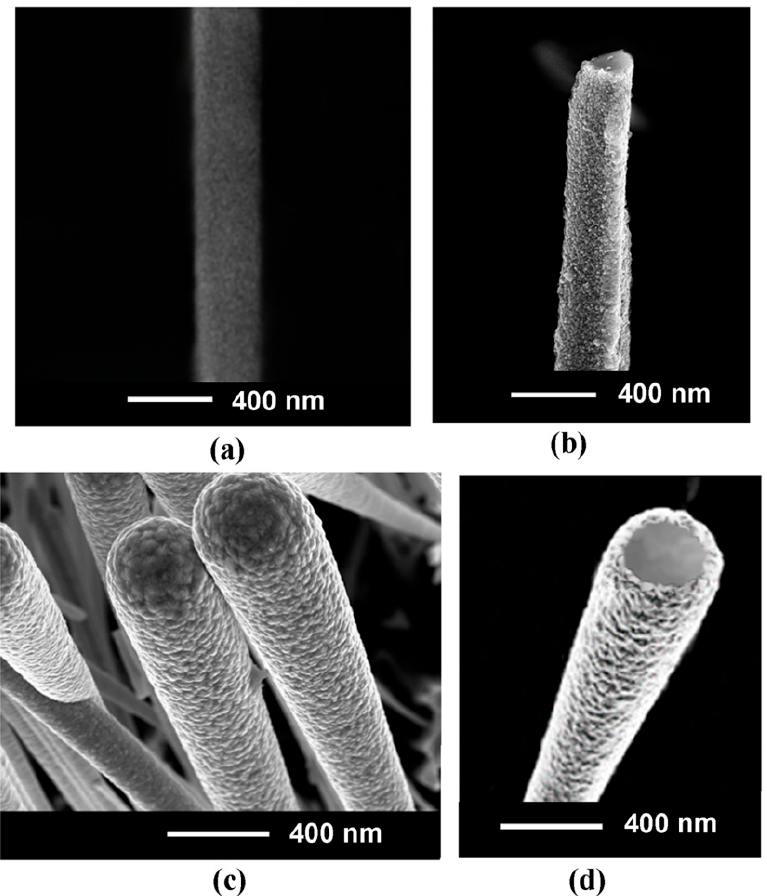
Figure 4. SEM images of an initial GaAs nanowire ( a ); a GaAs nanowire after Ni coating for 40 s and cutting in a plane perpendicular to the nanowire axis ( b ); a bunch of GaAs nanowires after Ni coating for 60 s ( c ); and a GaAs nanowire after Ni coating for 60 s and cutting perpendicularly to the nanowire axis ( d ).